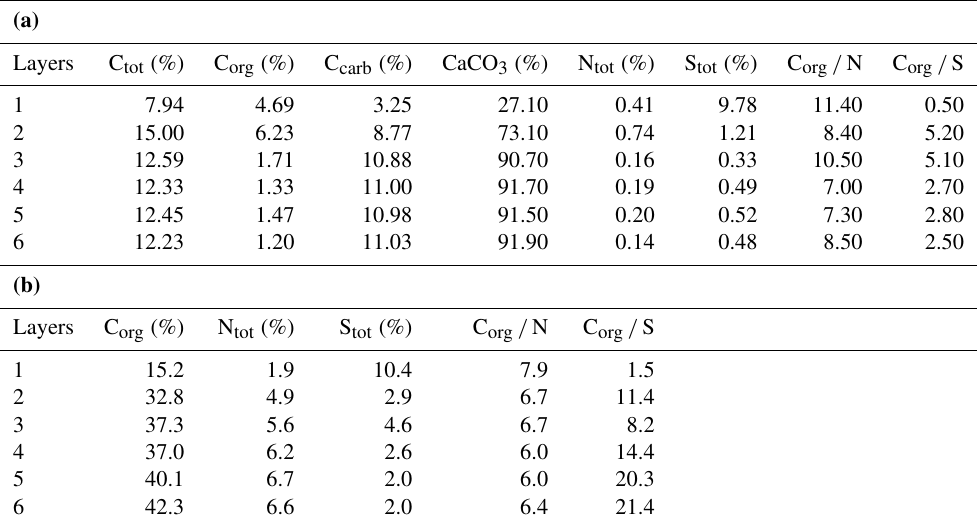
Table 1. (a) Bulk geochemical data for the microbial mat (original mat layers before decalcification). (b) Bulk geochemical data for the microbial mat (extraction residues after decalcification; modified after Blumenberg et al., 2015).